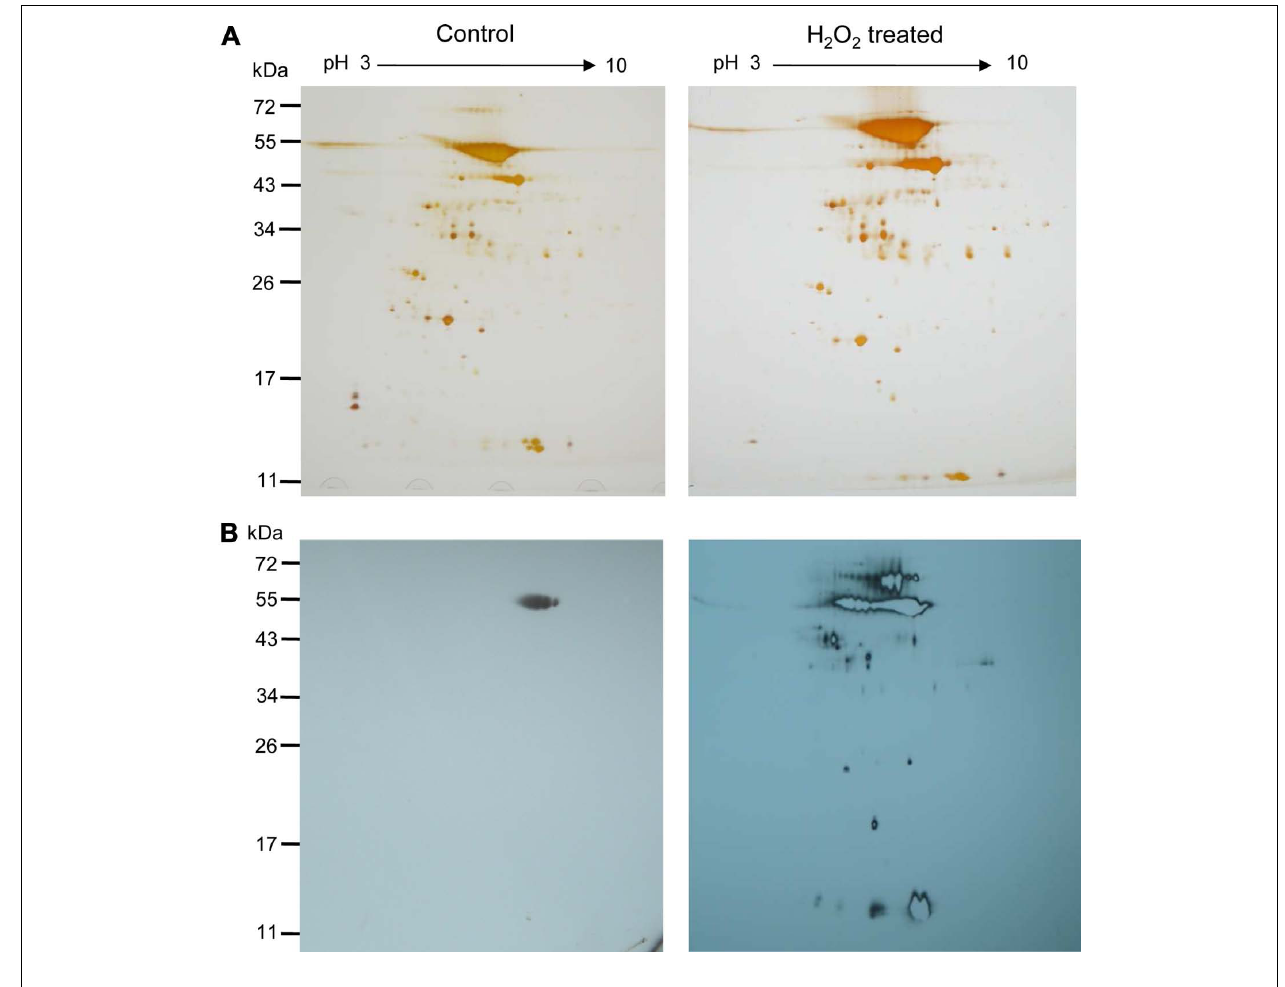
presented. (B) Two-dimensionalWestern blot map after decoration with anti-biotin antibody. Control and H 2 O 2 -treated samples of the respective gels are shown. Oxidized protein thiols were labeled with biotin maleimide as described.The figure is representative of three independent experiments. Molecular weight markers, in kDa, are indicated on the